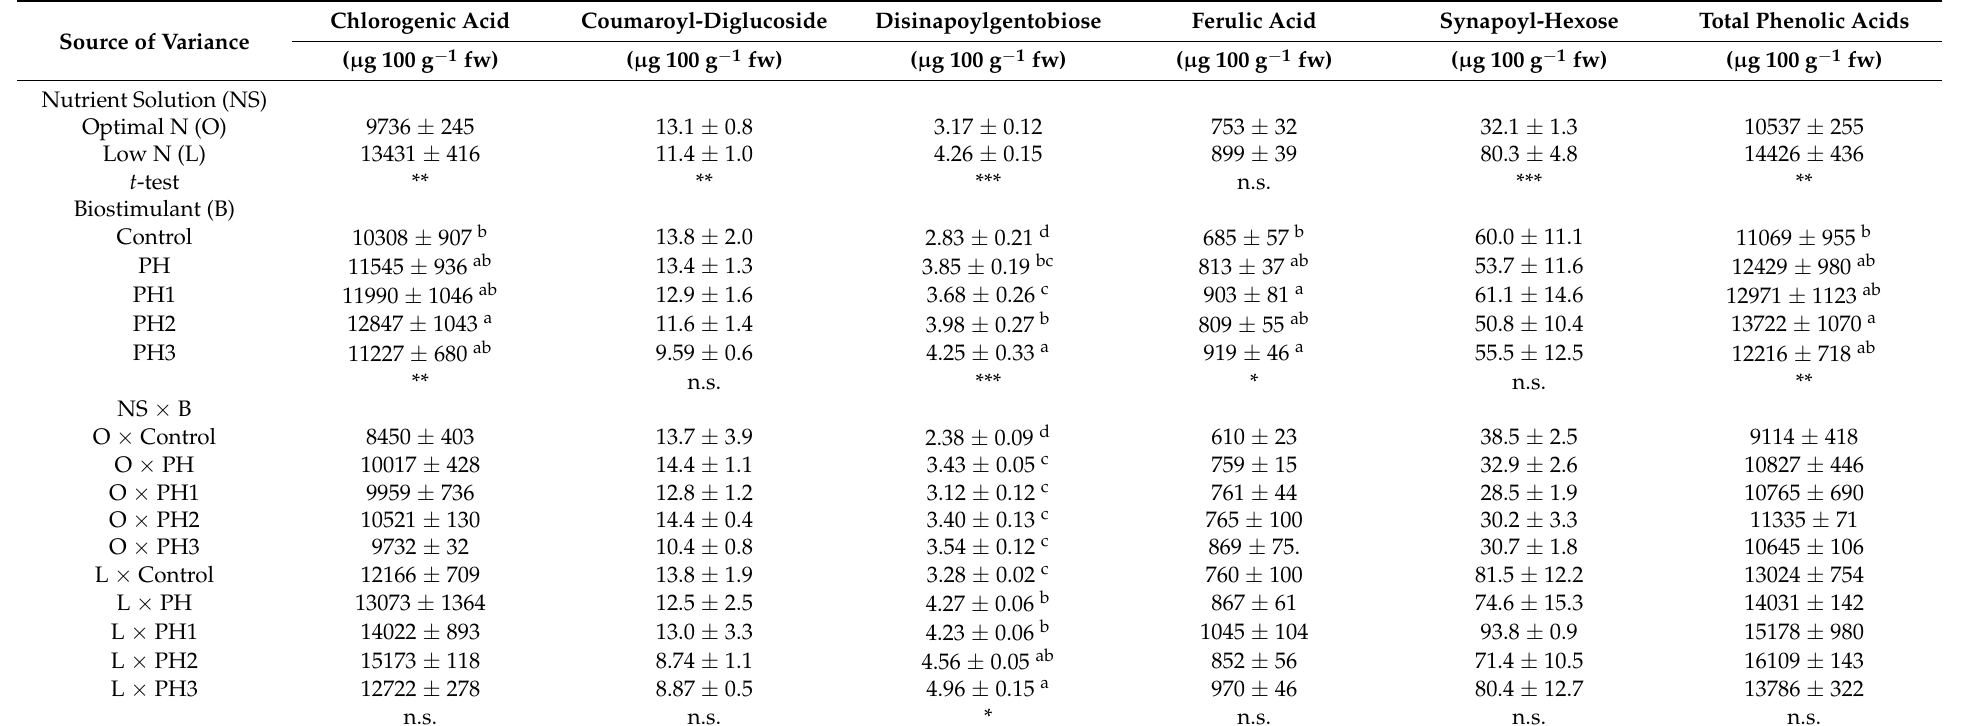
Table 3. Phenolic acids profile of lettuce plants as affected by nitrogen dosage and biostimulant